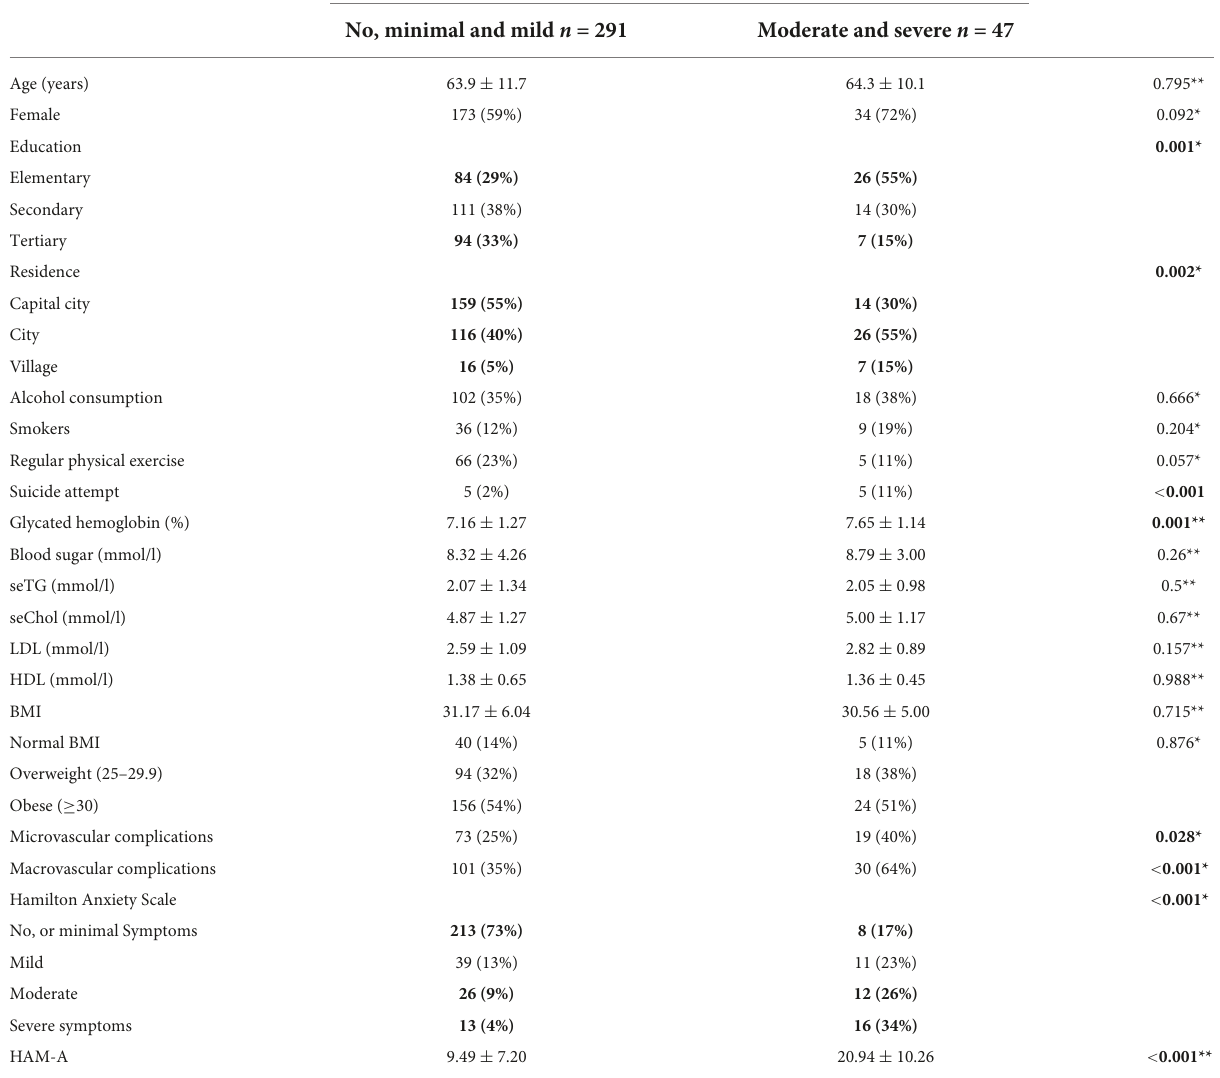
TABLE 2 The comparison of demographic and clinical characteristics of patients with type 2 diabetes by depressive symptoms severity in Hungary ( n = 338, 2018–2020).